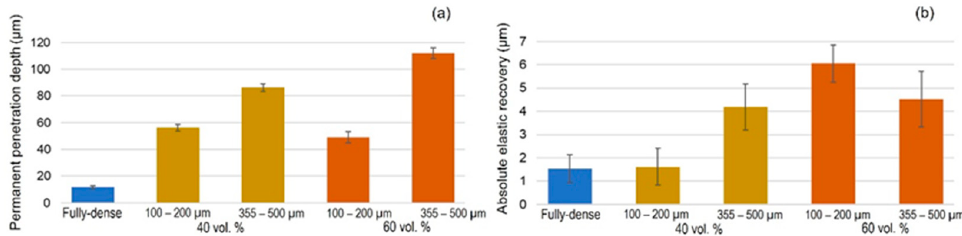
Figure 8. Scratch tests parameters on FSL-modified titanium substrates: ( a ) permanent penetration depth; and ( b ) absolute elastic recovery (difference between scratch in situ tests and permanent penetration depth).